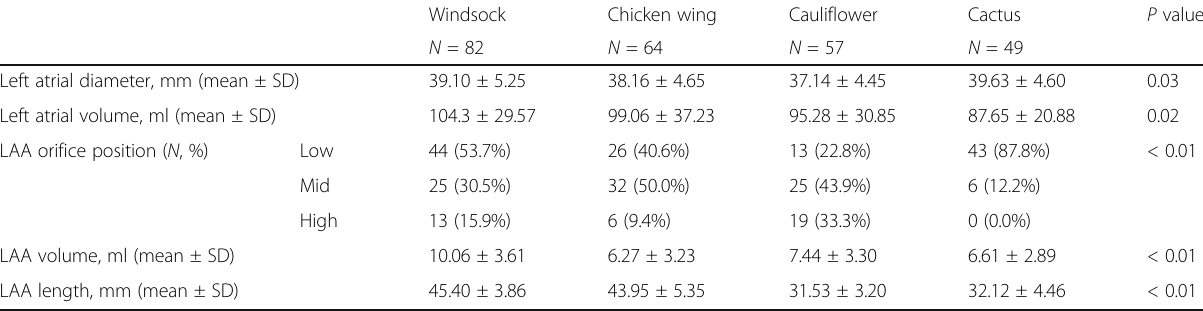
Table 2 Differences in the left atrium and left atrial dimensions in the 4 morphological types of the left atrial appendage